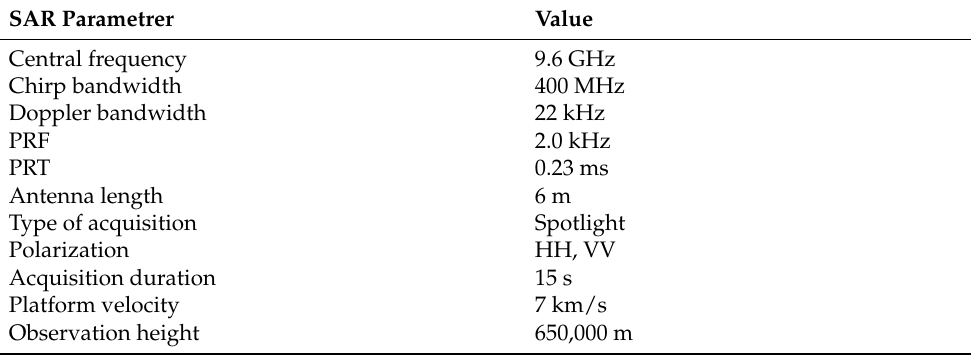
Table 1. Principal parameters of the SAR